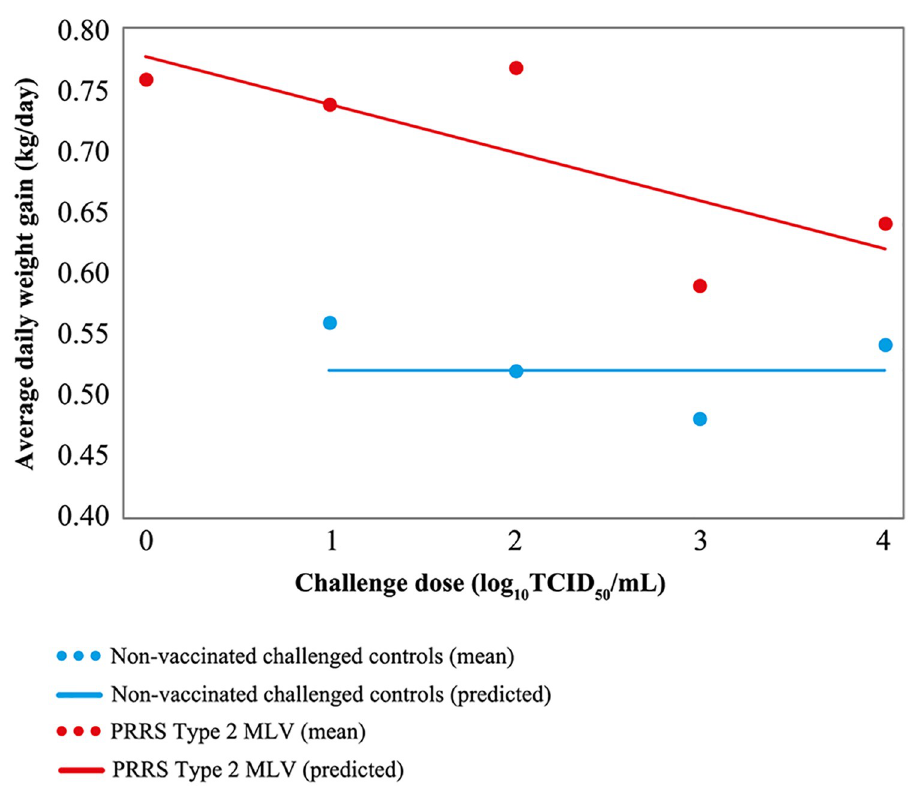
Fig 3. Estimated ADWG by challenge dose based on model prediction. Regression intercept and slope utilised to predict ADWG. Individual data points show mean ADWG for each challenge dose group as recorded between Days 28 and 70. ADWG = average daily weight gain; MLV = modified-live virus; PRRS = porcine reproductive and respiratory syndrome; TCID 50 = 50% tissue culture infectious